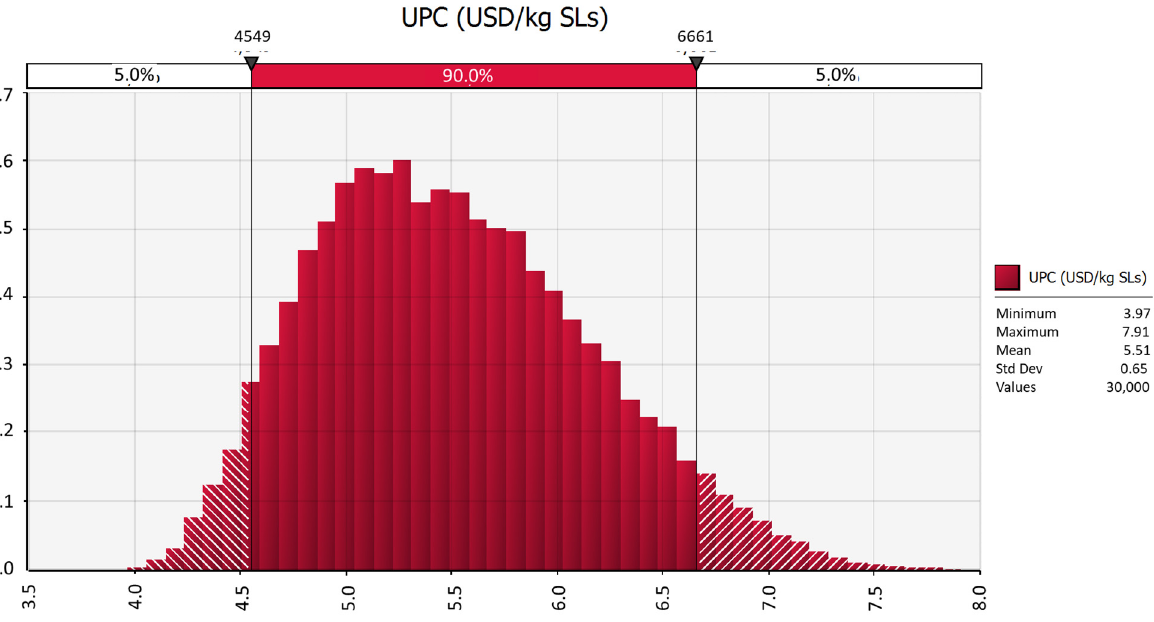
Figure 8. Sensitivity analysis on SL production from WOC by SSF on the unit production cost (UPC) for the WS scenario under the conditions assumed in the model. Nomenclature: WS: wheat straw; WOC: Winterization oil cake.